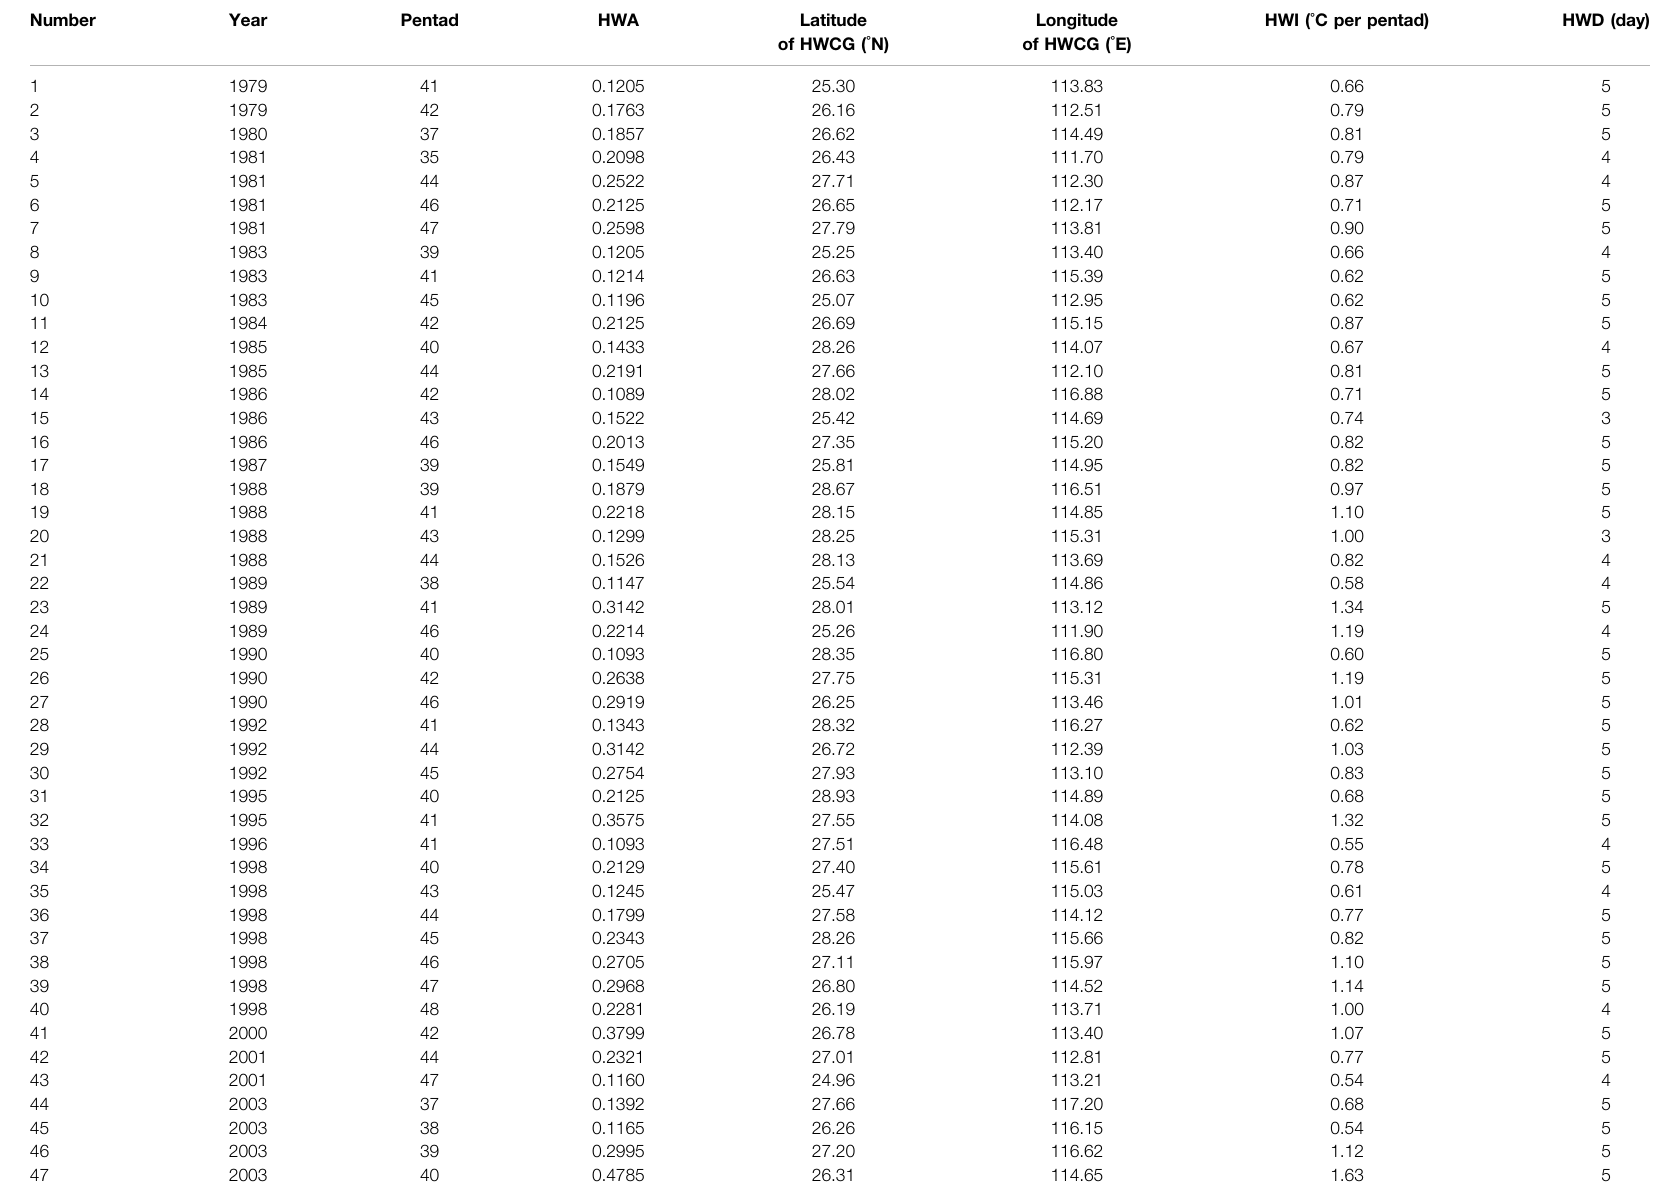
TABLE A3 | Same as Table A2 , but for RPHWs in